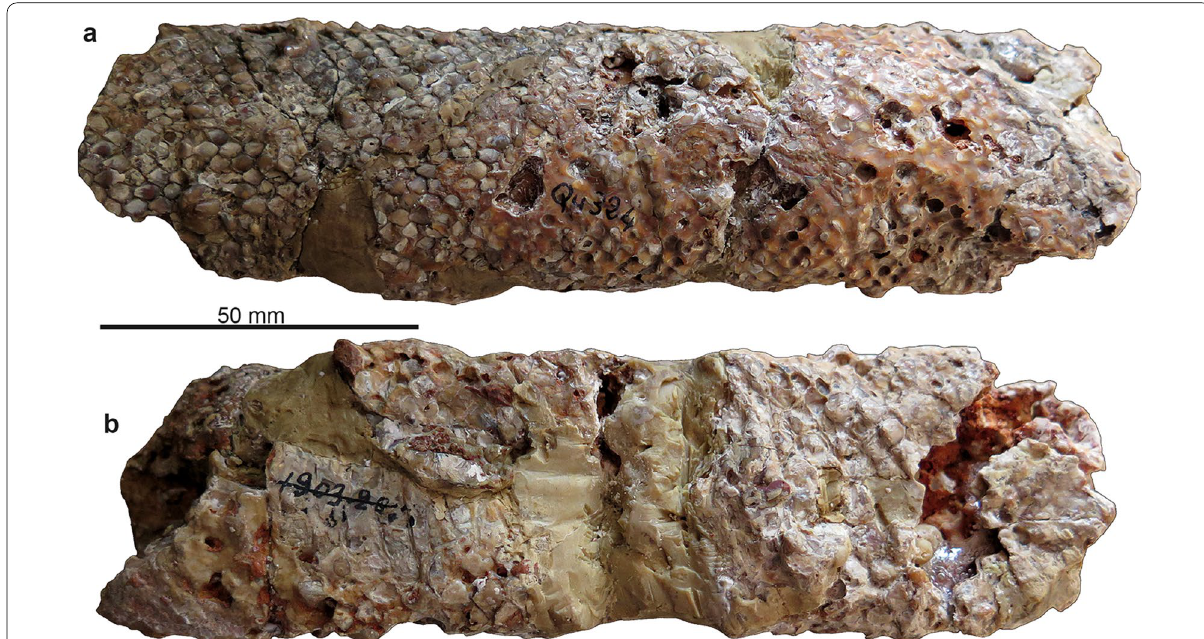
Fig. 42 Paralectotype “mummy” (MNHN.F QU16324) of “ Palaeopython ” neglectus from an imprecisely known locality in the Phosphorites du Quercy